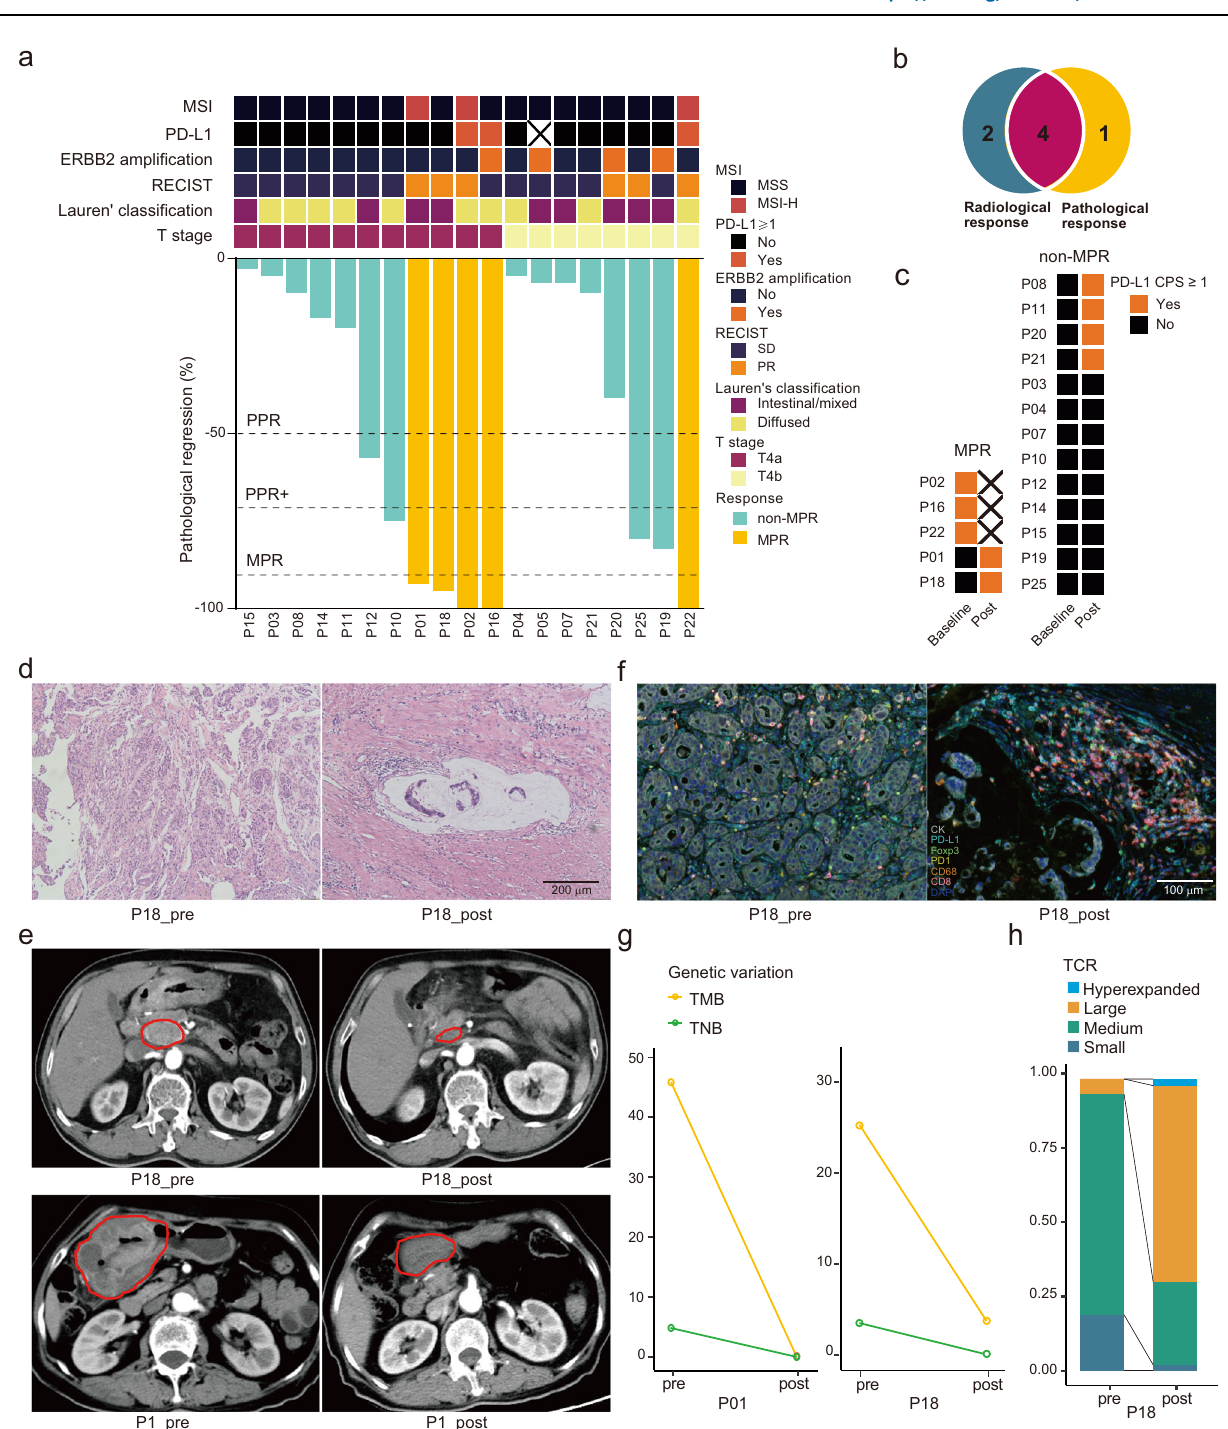
Fig.2|Pathological fi ndingsofresectedtumors.a PathologicalresponsesinT4a ( n =11) and T4b ( n =8) gastric cancer patients. Baseline features are shown in the top panel, while percentages of pathological regression are shown at the bottom. Dot lines indicate cutoff values of partial pathological response (PPR), PPR+, and major pathological response (MPR). b Overlap of partial response by radiological examination and MPR. c Dynamic changes of PD-L1 expression positivity. d Representative hematoxylin and eosin staining sections of tumor specimens obtained from patient P18, who obtained MPR. e Representative computed tomographicimaging of alymphnode(top)and the